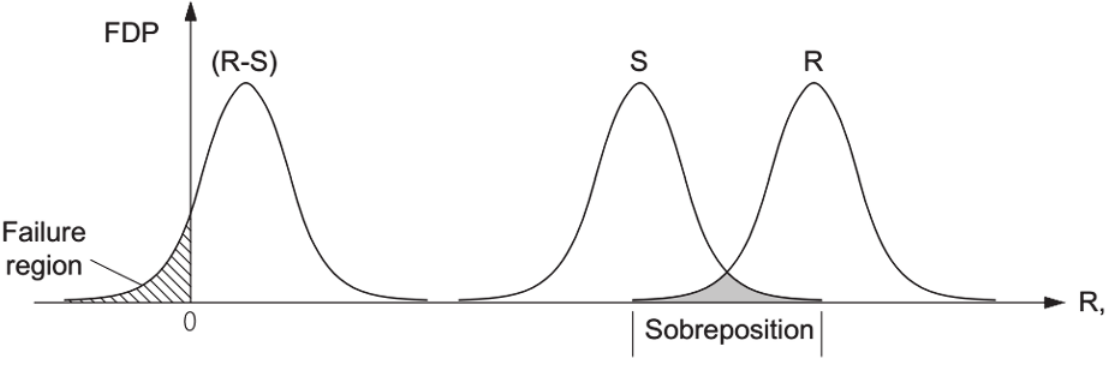
Figure 5.1 Load-displacement plot for the specimen